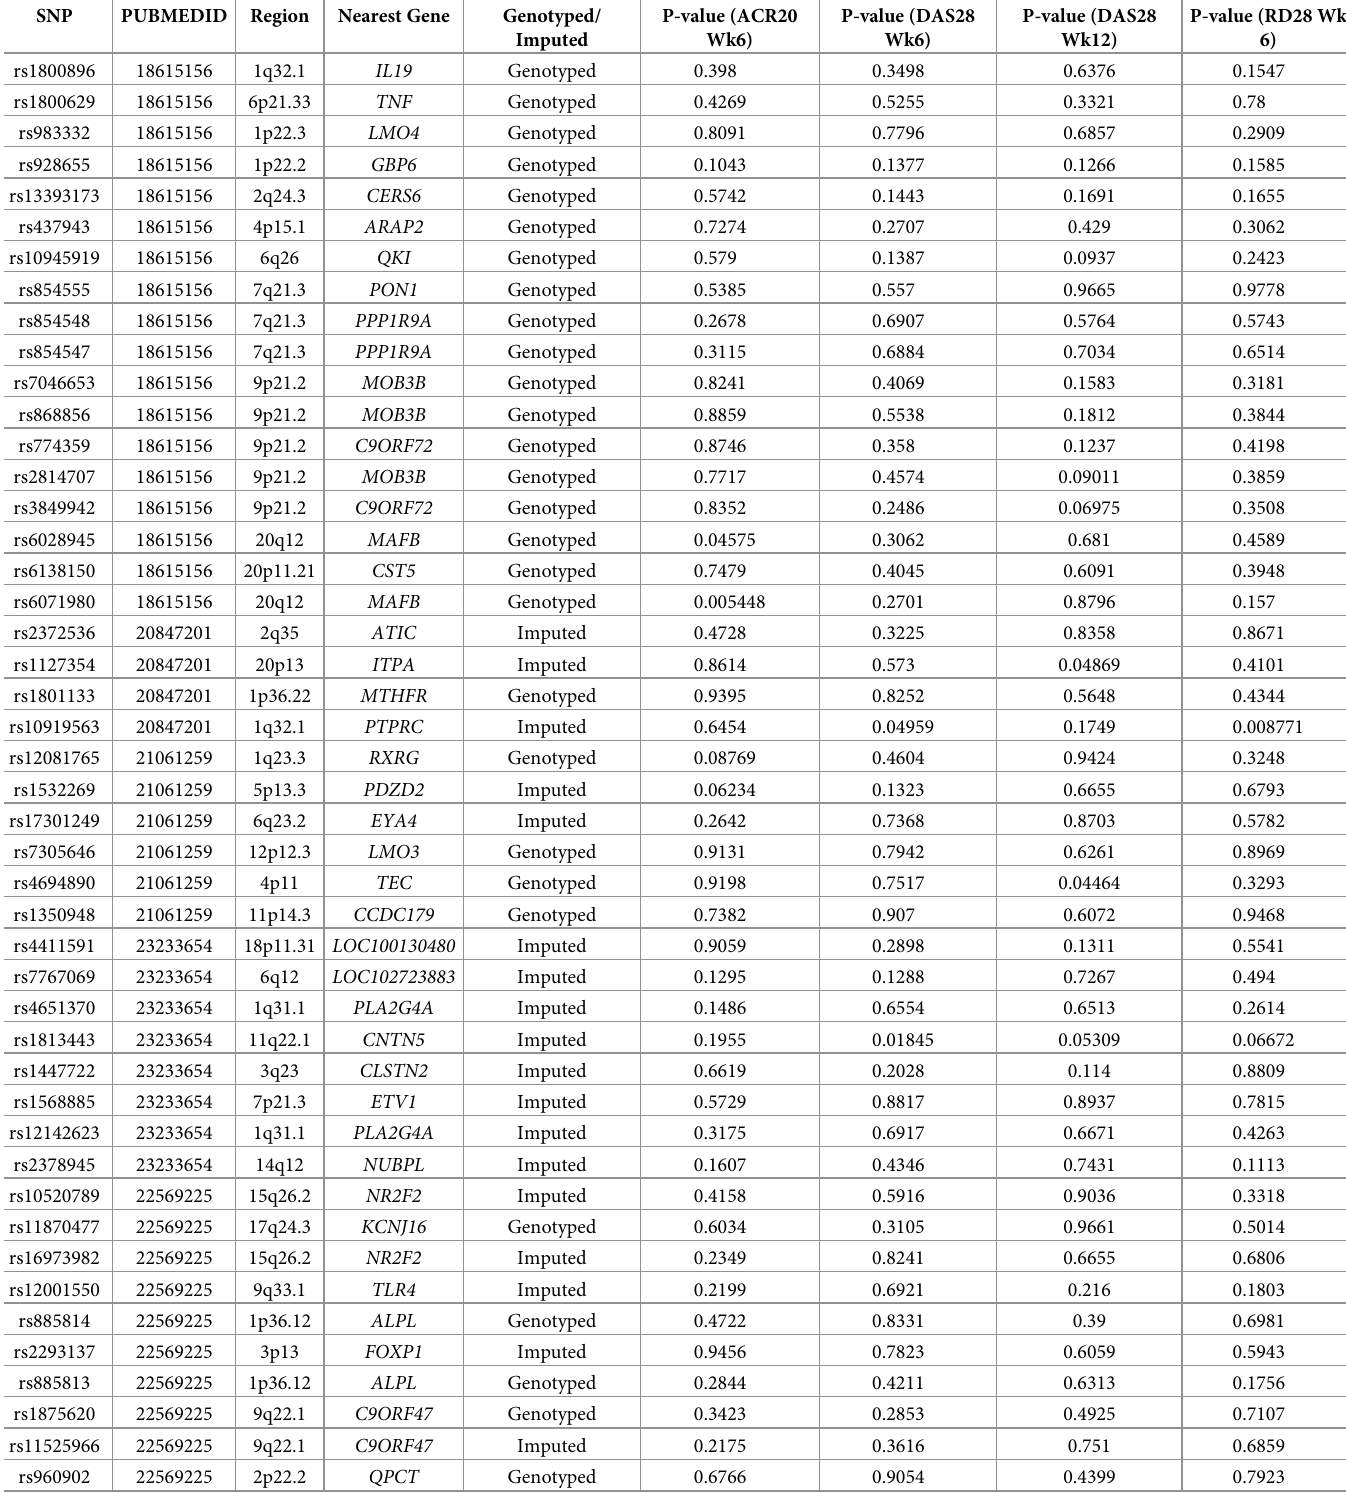
Table 4. SNPs previously associated with therapeutic response to TNF